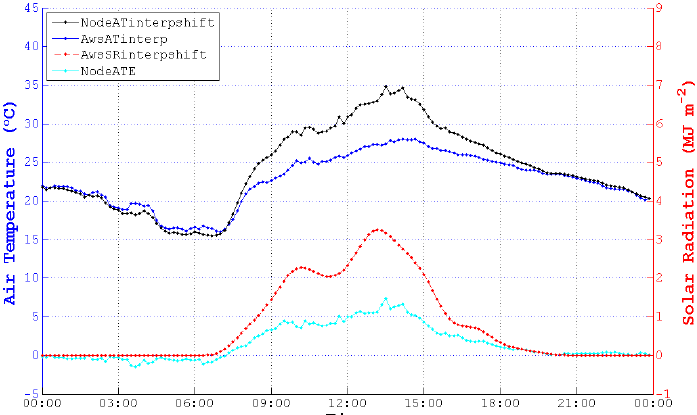
Figure 9. AT and SR after time shifting on 13 May 2014. NodeATinterpshift and AwsSRinterpshift are shifted data corresponding to NodeATinterp and AwsSRinterp. AwsATinterp is the interpolated data as before. NodeATE is the deviation between NodeATinterpshift and AwsATinterp.